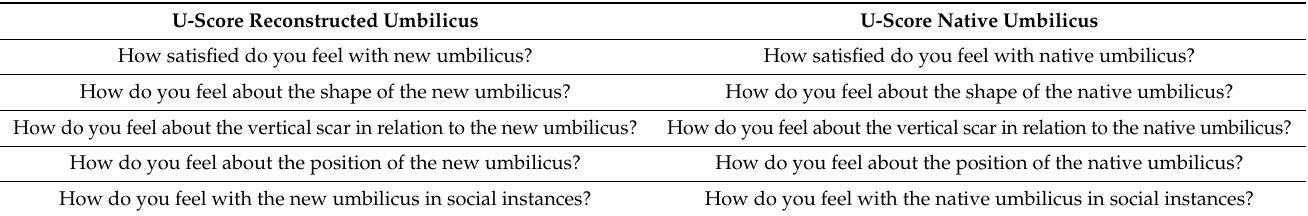
Table 2. The Table 2. The U-Score.